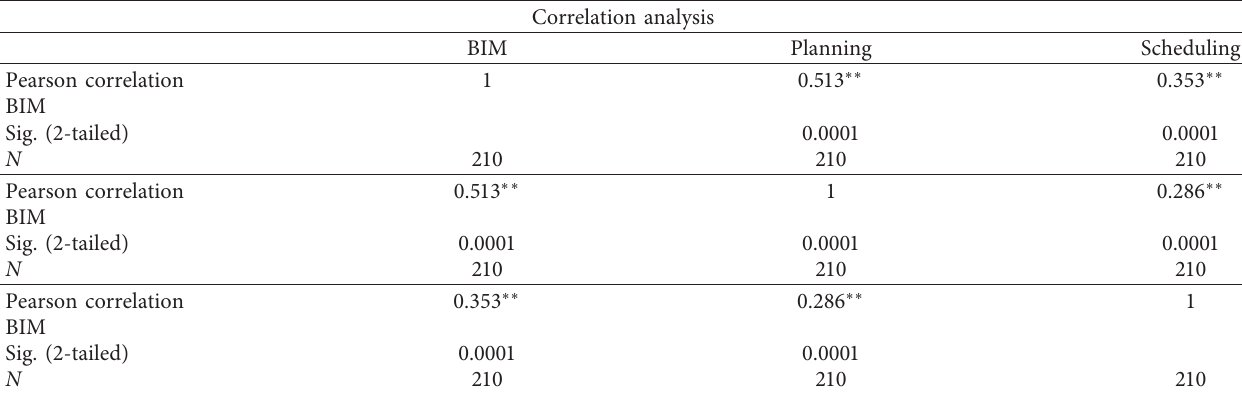
Table 3: Correlation analysis between BIM, planning, and